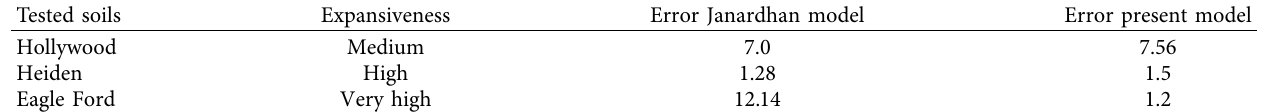
Table 7: Summary of the cumulative error found in the suction-based correlation for swell pressure.